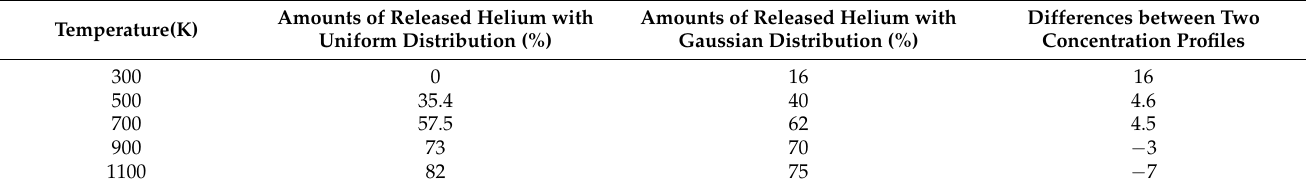
Table 4. Amounts of released helium with different concentration profiles at different tempera- tures.